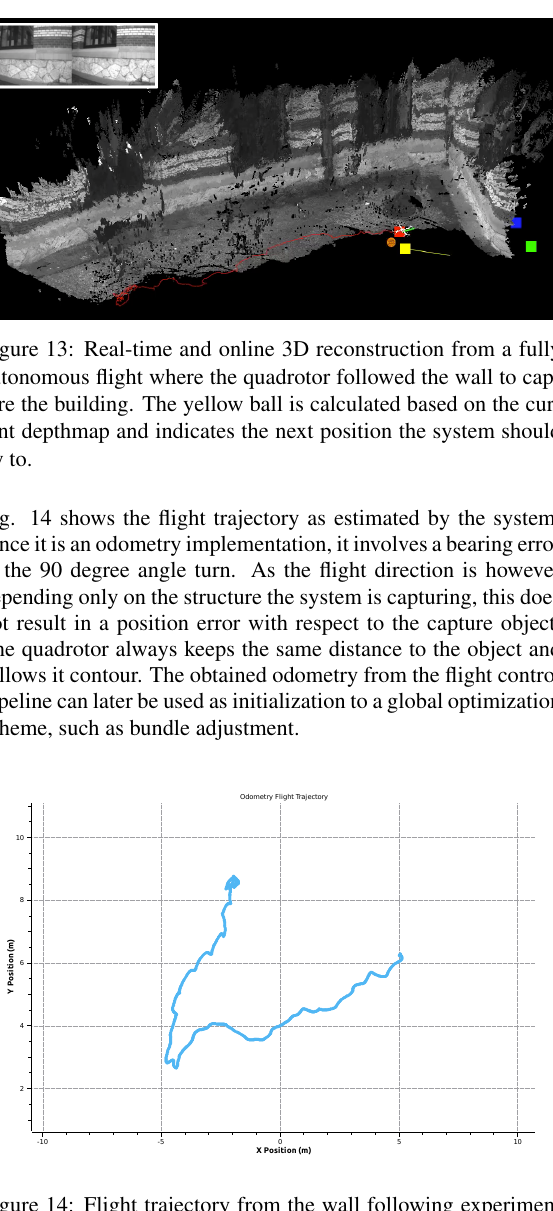
Figure 14: Flight trajectory from the wall following experiment computed by the online onboard odometry. The trajectory is not globally correct but it can be used as an initialization for global